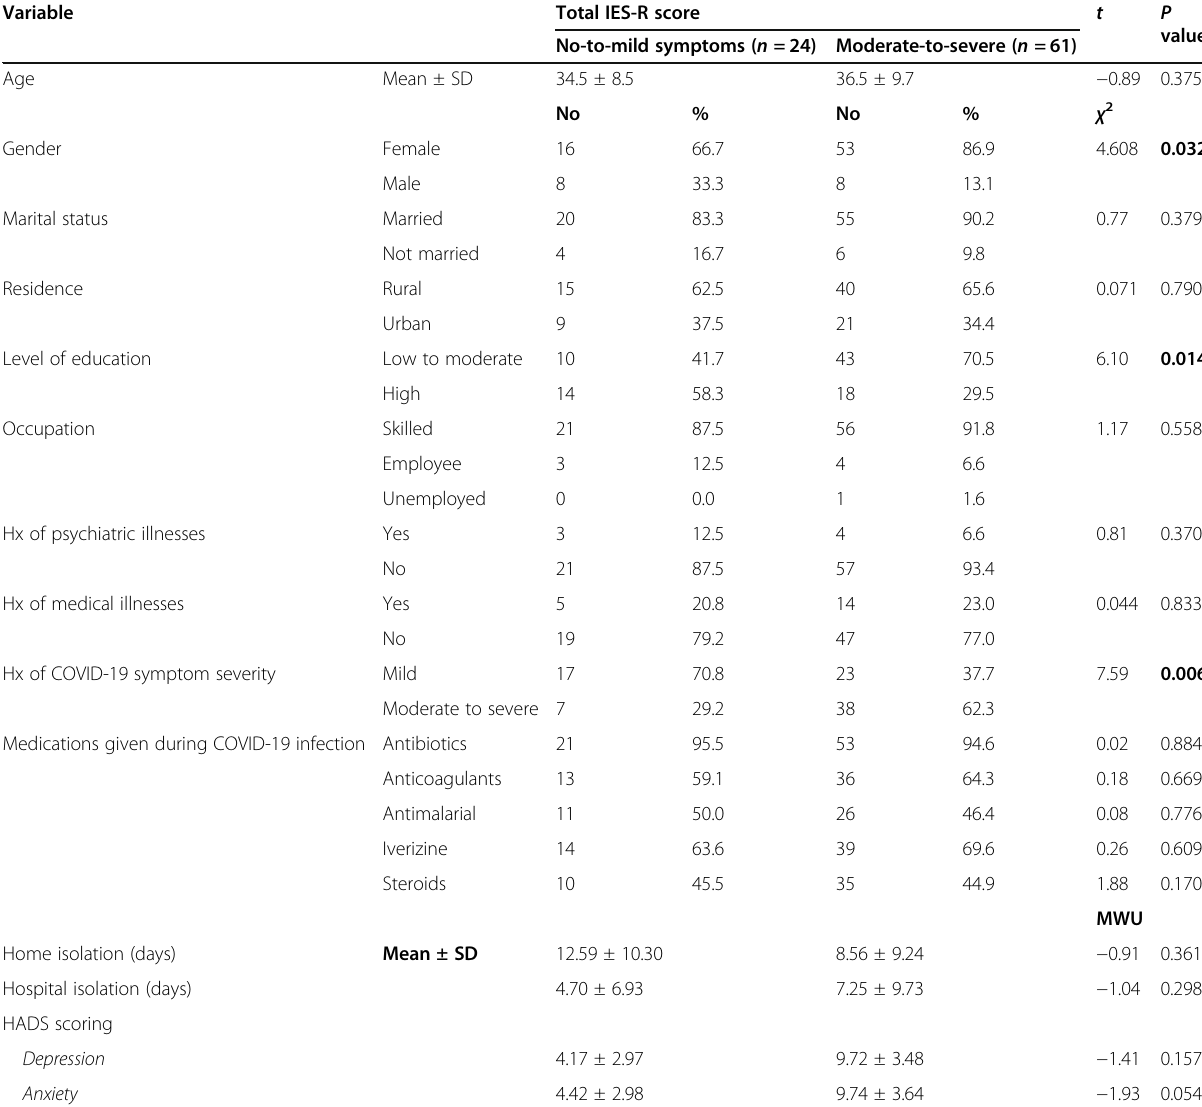
Table 4 Factors associated with PTSD symptoms among COVID-19 survivors Variable